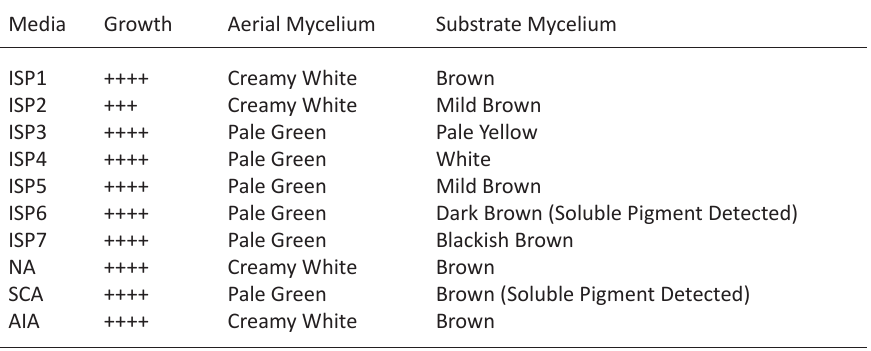
Table 4. Cultural characteristics of isolate SKCMM1 on International Streptomyces Project media. Media